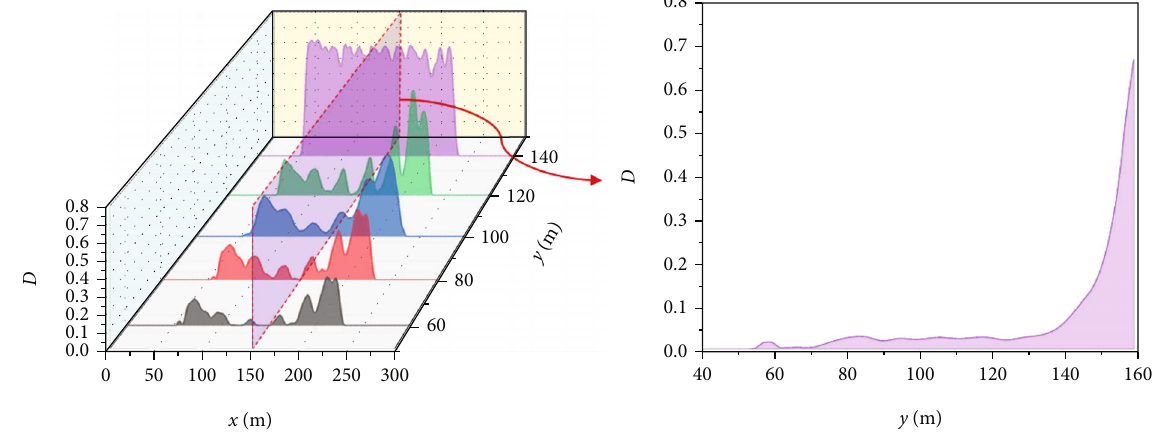
Figure 9: Roof damage